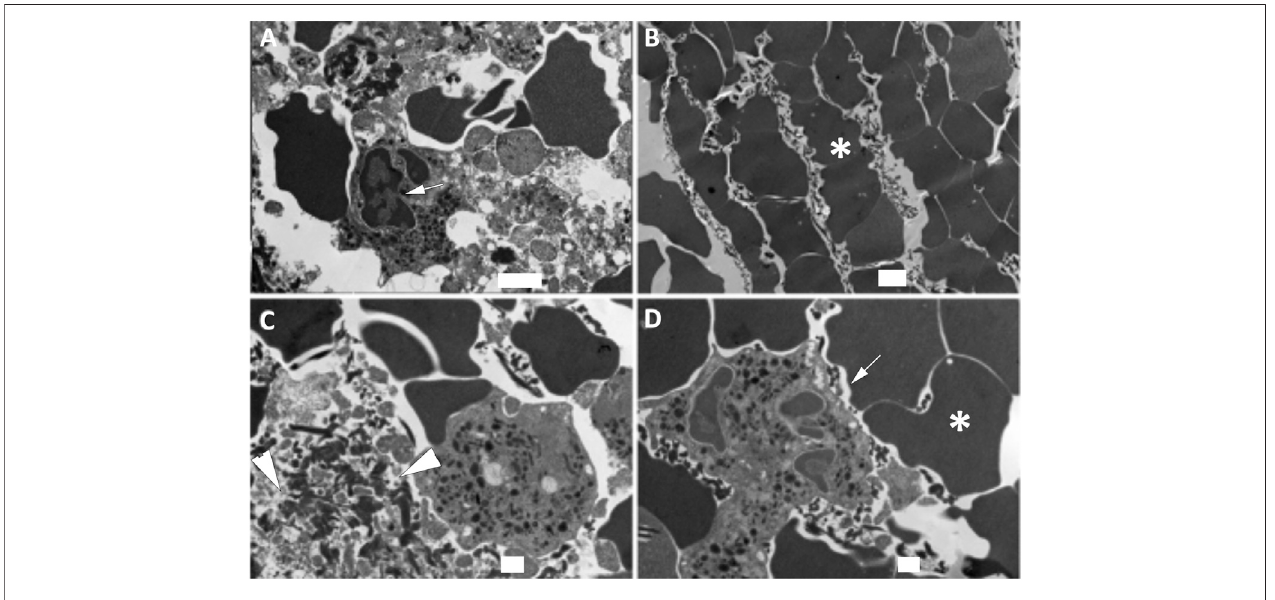
FIGURE 2 | TEM of clots from AIS patients. Clots were processed for TEM indicating the presence of granulocytes (arrows, A and D) , red blood cells (asterisk, B and D) , dying neutrophils (arrow heads, C) consistent with the presence of NETs in the clots of these patients. Scale bars: (A) 2 μ m, (B) 2 μ m, (C) 1 μ m, (D) 1 μ m.